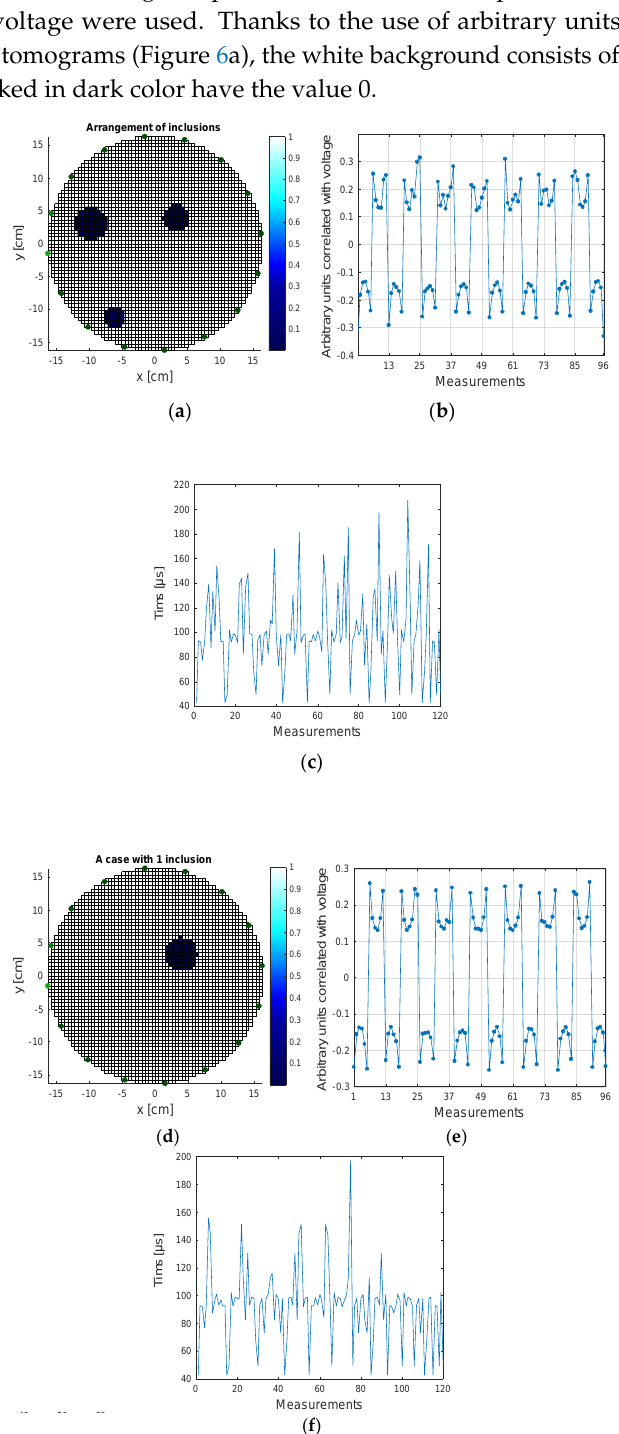
Figure 6. Real cases of measurement: ( a,d ) tomograms, ( b,e ) EIT arbitrary units correlated with voltage, ( c,f ) UST sound wave flight times between all transducers.